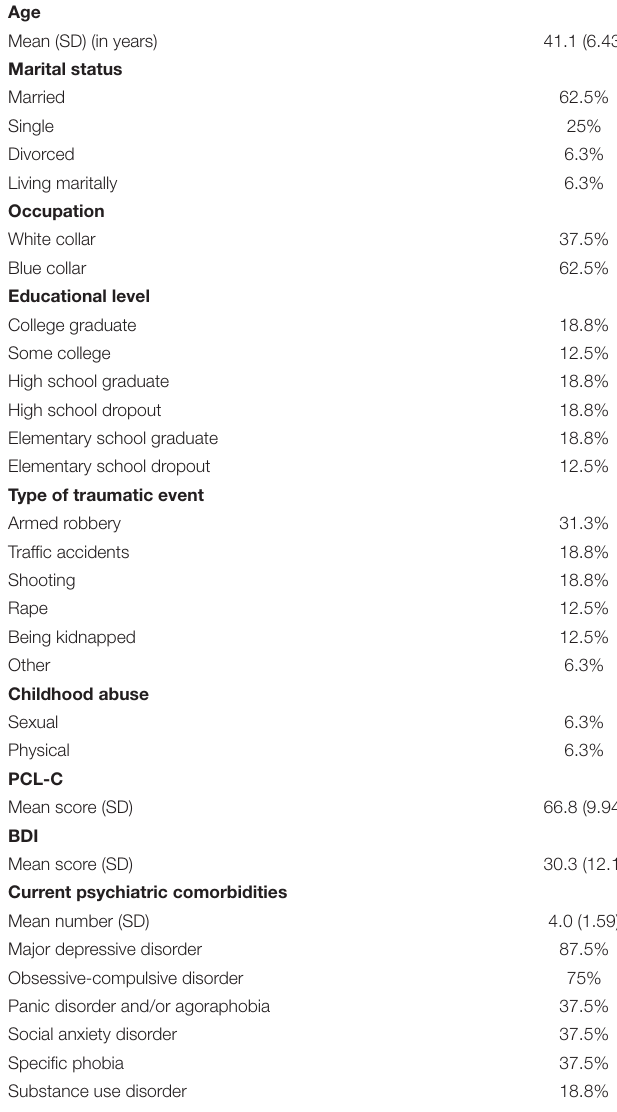
TABLE 1 | Socio-demographic, trauma-related and clinical characteristics of the sample ( n =